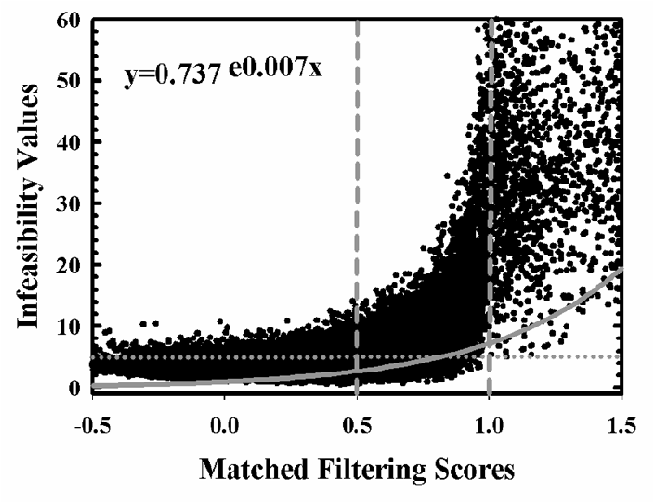
Figure 3. Aspen presence and absence classification of 2005 Landsat TM5 multitemporal composite using Mixture Tuned Matched Filtering (MTMF) technique with a regression approach. The exponential regression model was fitted to the MTMF-produced matched filtering scores and infeasibility values ( R 2 = 0.57, p < 0.0001). Pixels that fell under the regression curve (solid grey line) that had matched filtering scores of 0.5–1 (dashed grey lines) and infeasibility values of <5 (dotted grey line) were classified as aspen presence. All other pixels were classified as aspen absence.